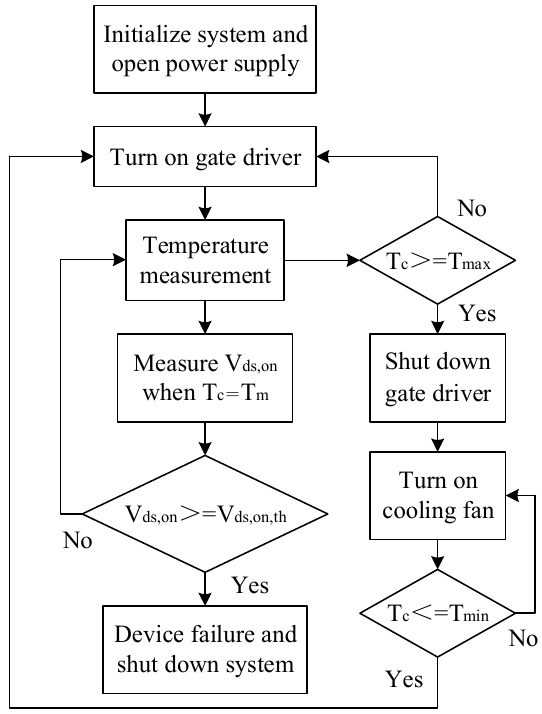
Figure 3. The program flow of the experiment.